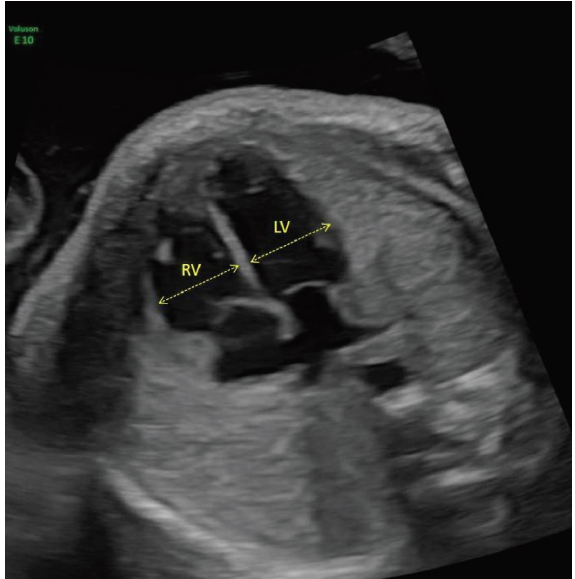
Figure 2: Standard 2D greyscale ultrasound image of the 4-chamber view of the fetal heart, illustrating balanced right (RV) and left ventricles (LV) (legend: RV � right ventricle and LV � left ventricle.).